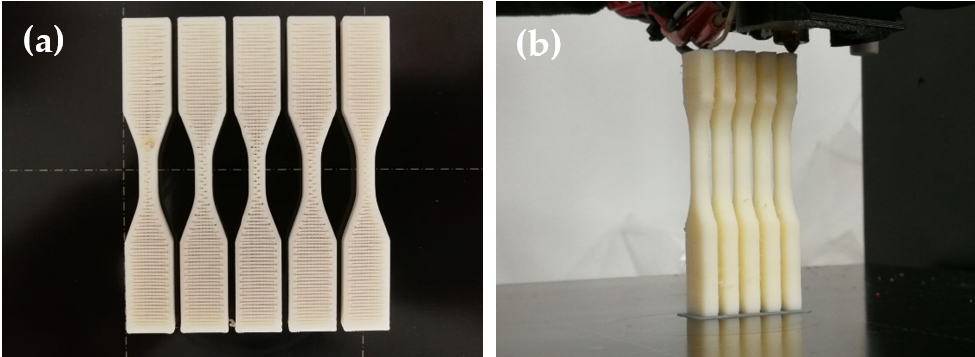
Figure 1. ABS samples in printing: ( a ) one batch of five longitudinal samples; and ( b ) one batch of five transverse samples.